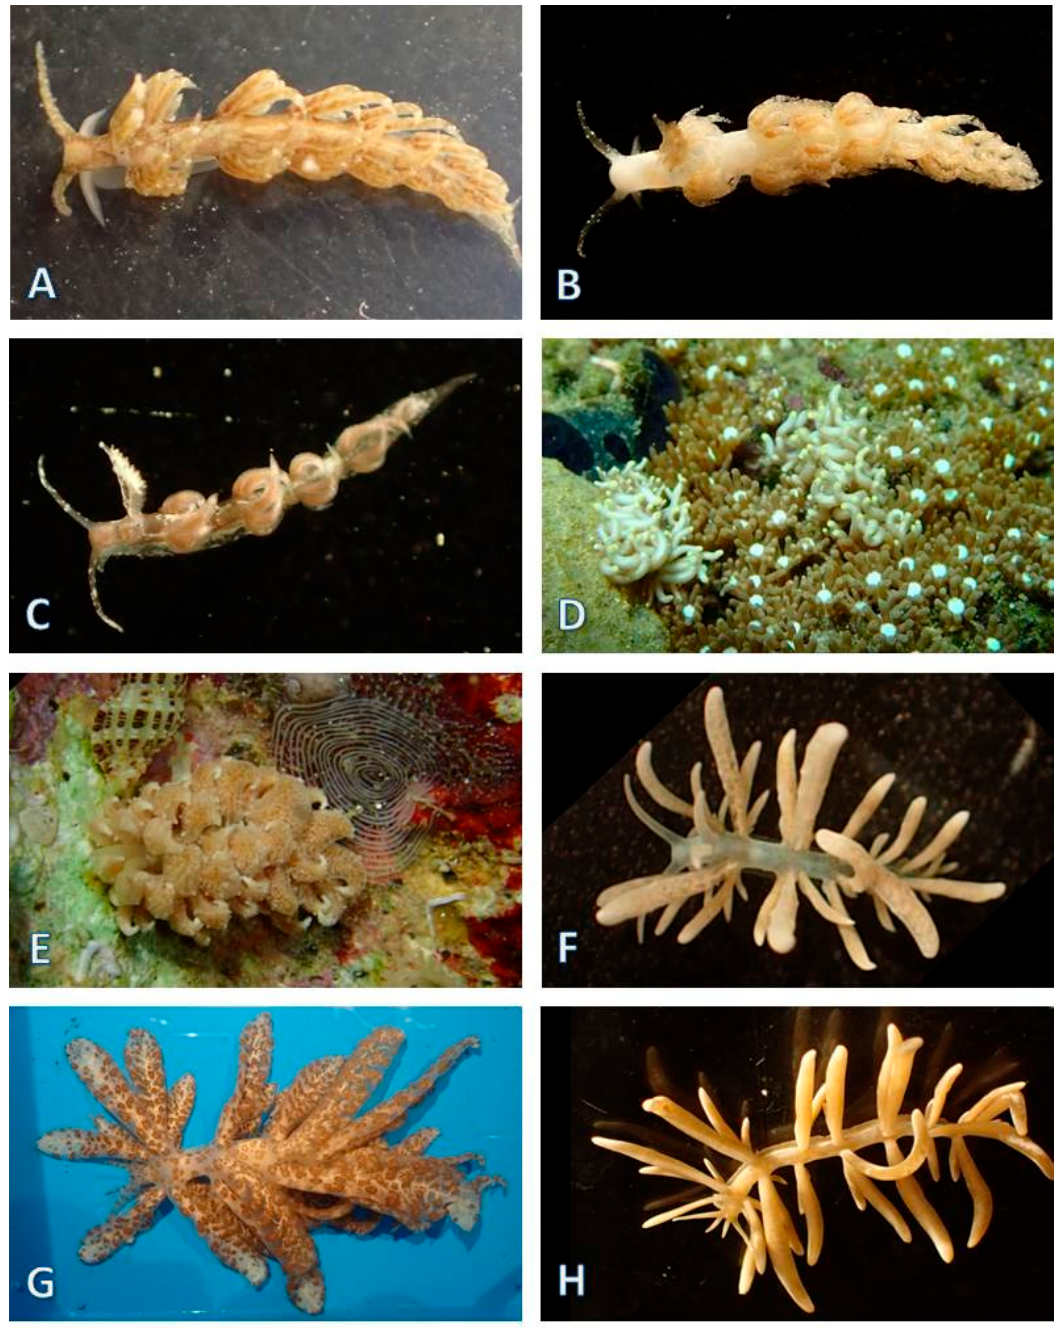
Figure 23. Nudibranchia Cladobranchia: ( A ) Noumeaella sp. ( Noumeaella sp. 2 in Gosliner et al. [24]: 367), Nosp2_17Ba-1; ( B ) Noumeaella sp. ( Noumeaella sp. 3 in Gosliner et al. [24]: 367), Nosp3Ba-3; ( C ) Noumeaella sp. ( Noumeaella sp. 13 in Gosliner et al. [24]: 369), Nosp13Ba-4 ; ( D ) Phyllodesmium briareum, Phbr18Ba-2-16; ( E ) Phyllodesmium cf. crypticum, Phcr17Ba-4; ( F ) Phyllodesmium lizardense, Phliz18Ba-3 ; ( G ) Phyllodesmium longicirrum, Phlo18Ba-1; ( H ) Phyllodesmium magnum, Phma18Ba-1 .